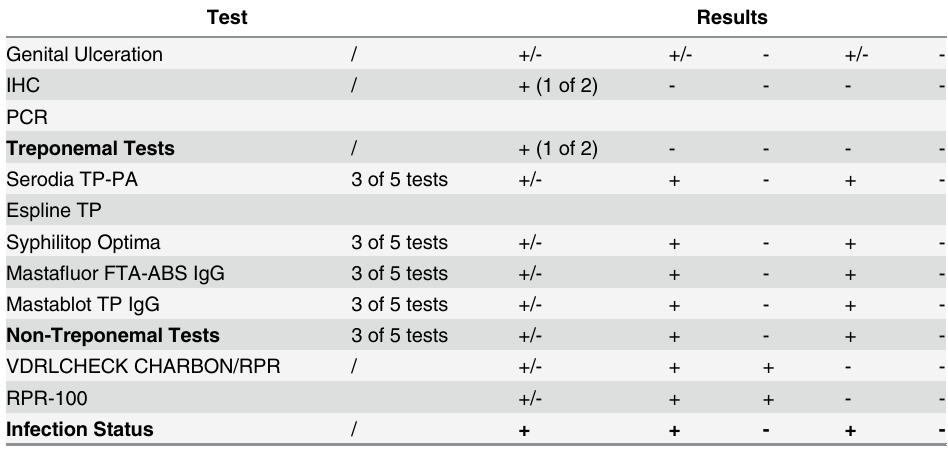
Table 2. Definitions used to determine the infectious stage of baboons.